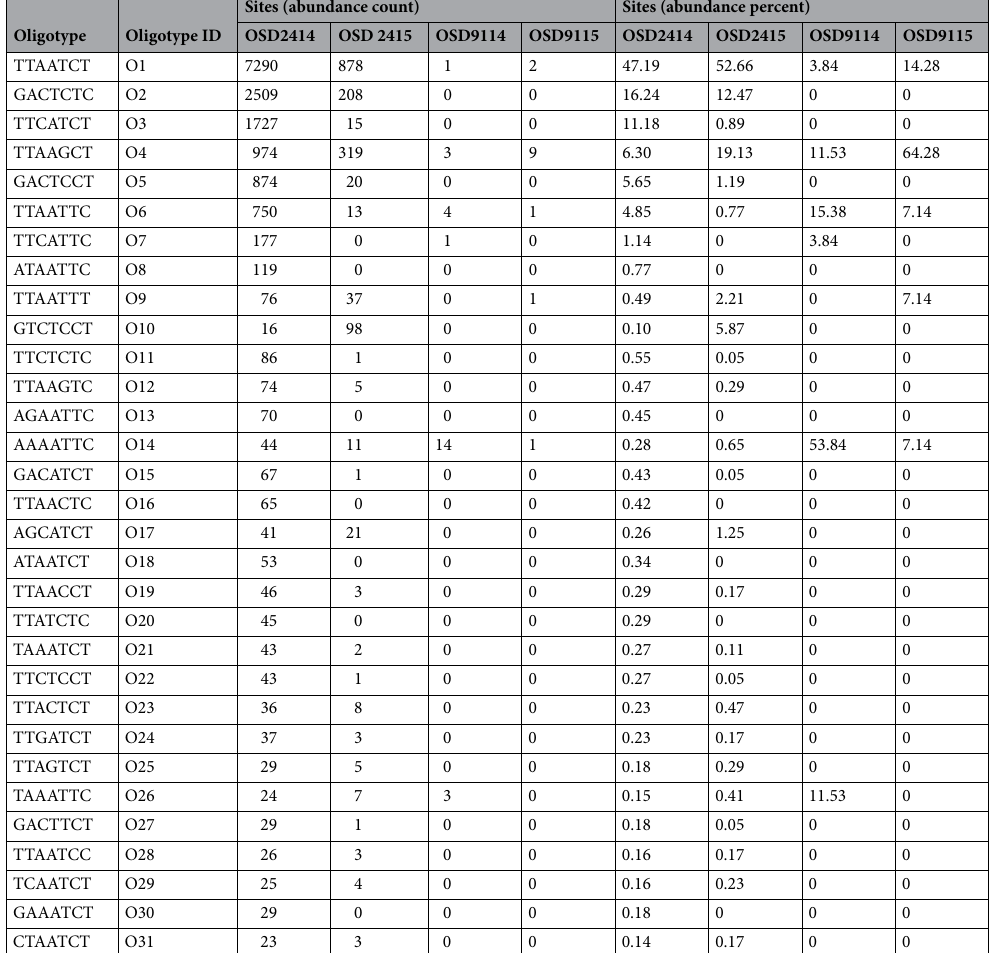
Table 1. V4–V5 Oligotype observation matrix. *OSD2414: Marchica Lagoon 2014 sampling; *OSD2415: Marchica Lagoon 2014 sampling. *OSD9114: Oualidia lagoon 2014 sampling; *OSD9115: Oualidia lagoon 2015